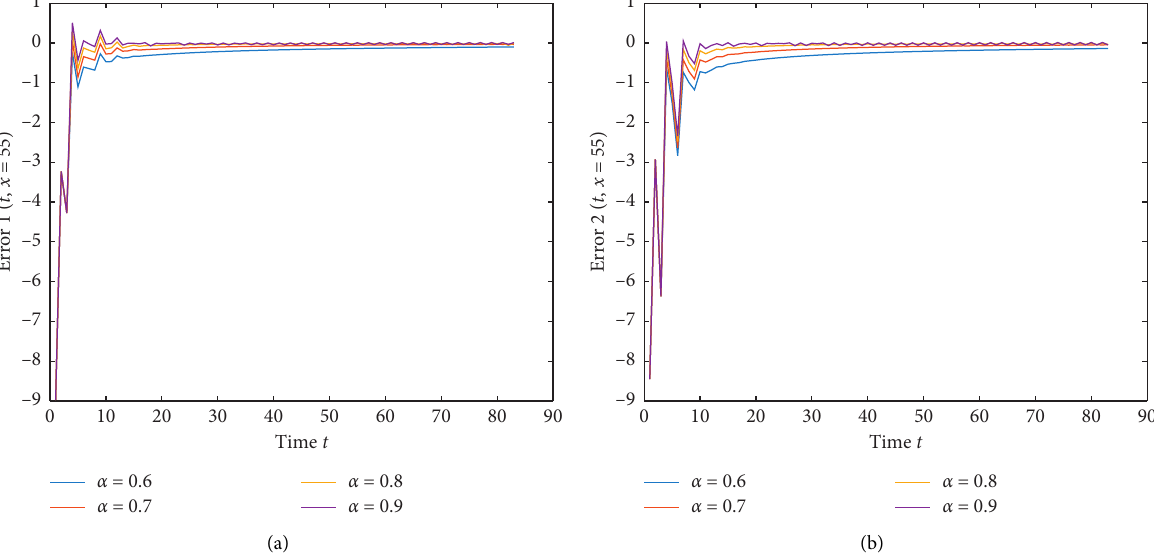
Figure 3: Trajectories of error system (26) at spatial position x � 55 under different